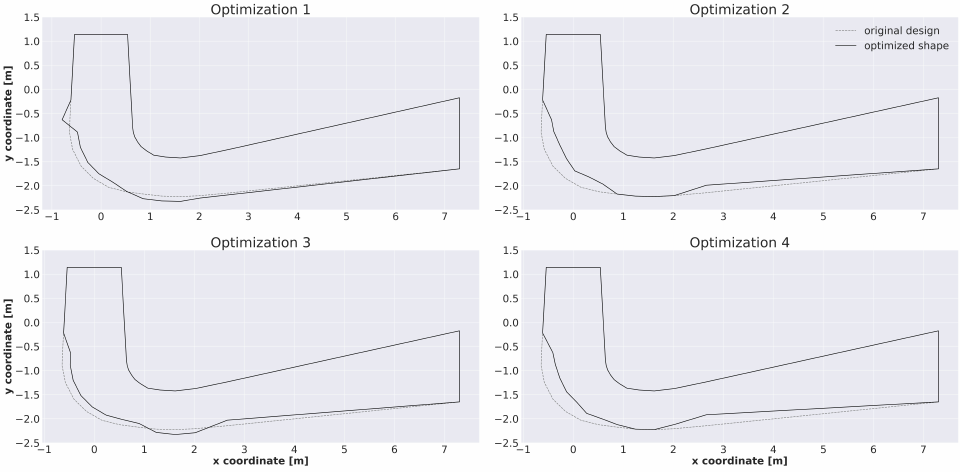
Figure 4. Overlapping visualization of original geometry and optimized shapes for different op- timization goal functions and variable constraints. In the first column, additional excavation was allowed and in the second column, no excavation was